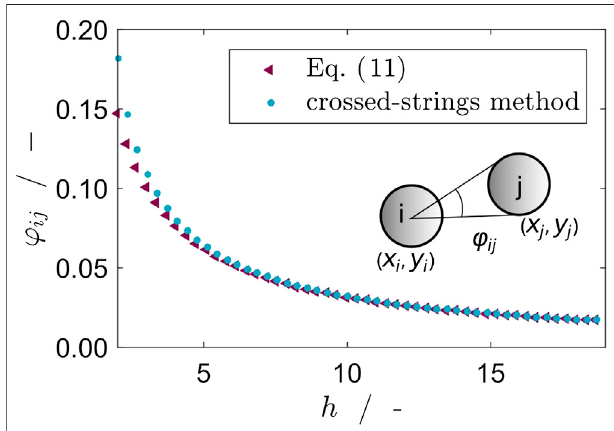
FIGURE3| Viewfactorsbetweentube i and j : φ ij calculatedusingEq.12 (red triangles) and compared with the crossed-strings method (blue circles) vs. the distance ratio h : (cid:2) l ij / r